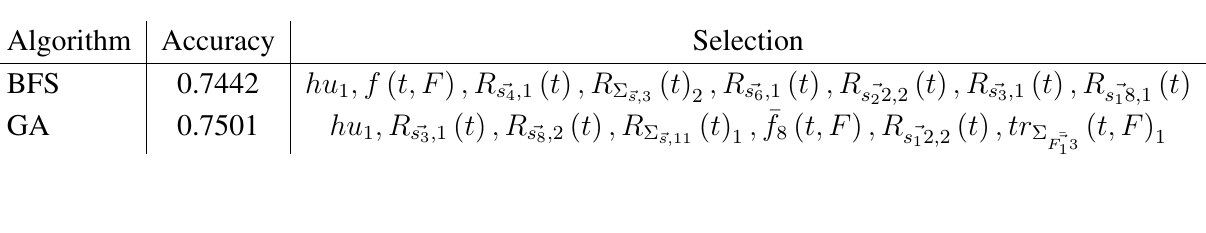
Table 10. Results obtained by Best First Search (BFS) and Genetic Algorithm(GA) using all the training sequences